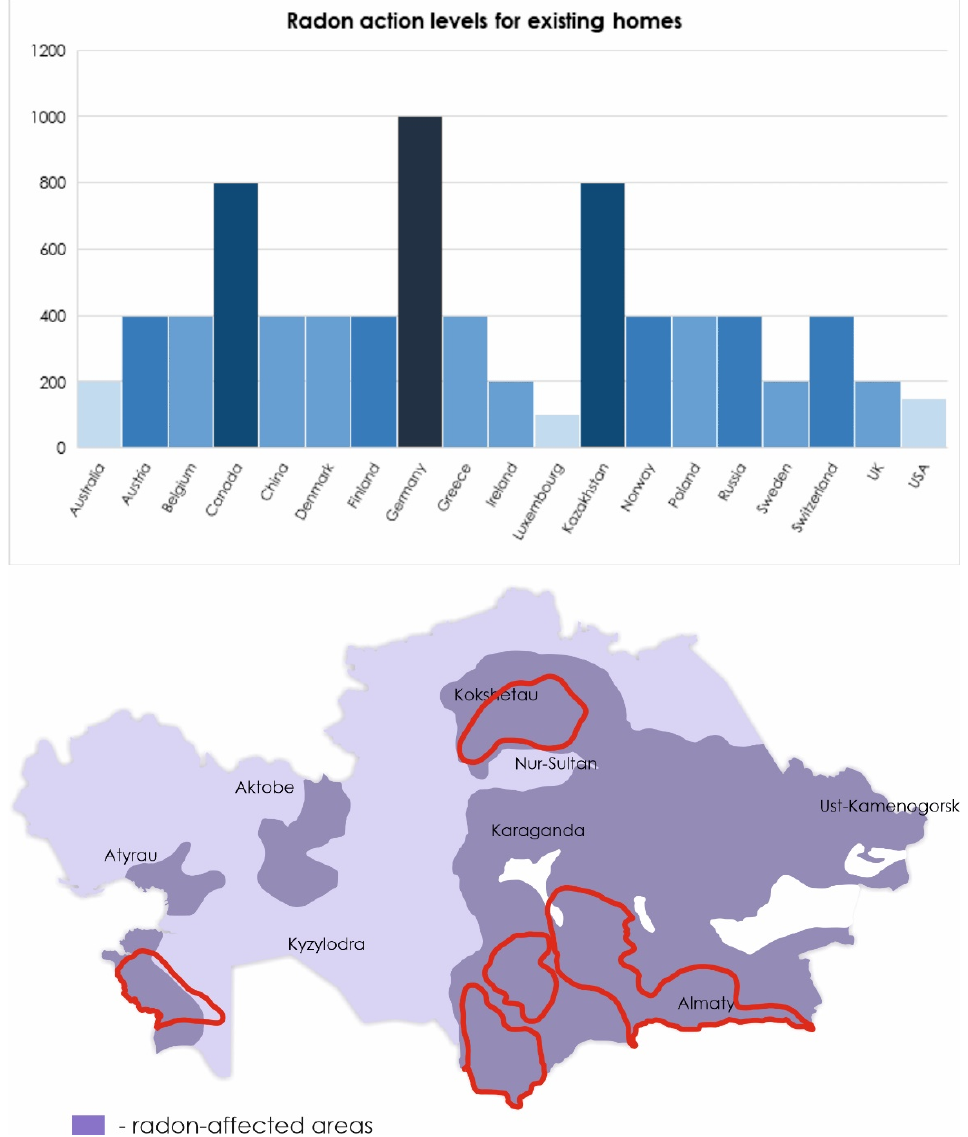
Figure 2. Radon levels in different countries according to the World Health Organization (WHO) handbook [5]. Level of radon in Kazakhstan presented according to [22,37]. The borders of natural uranium mining zones are highlighted in red.